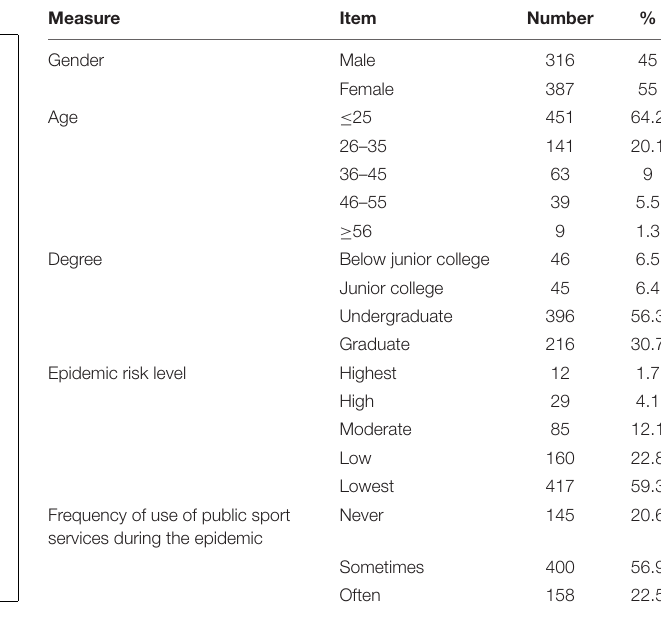
Table 1 . The proportion of men and women in the survey sample